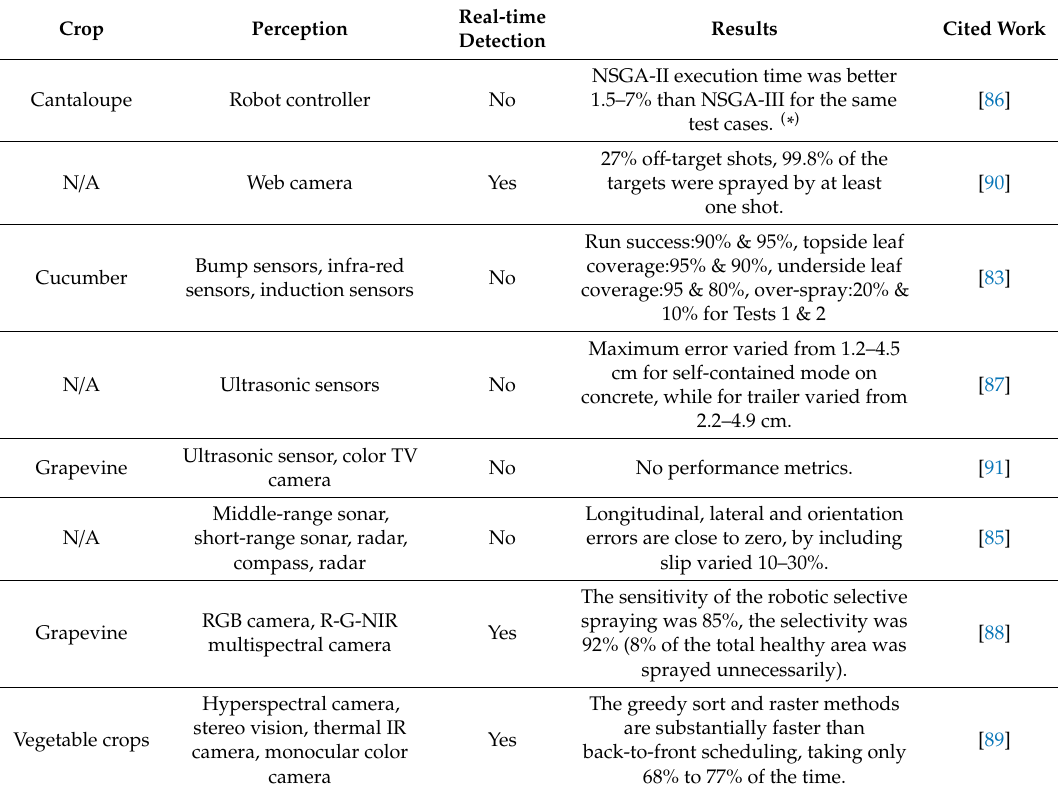
( * ) NSGA: Non-dominated Sorting Genetic